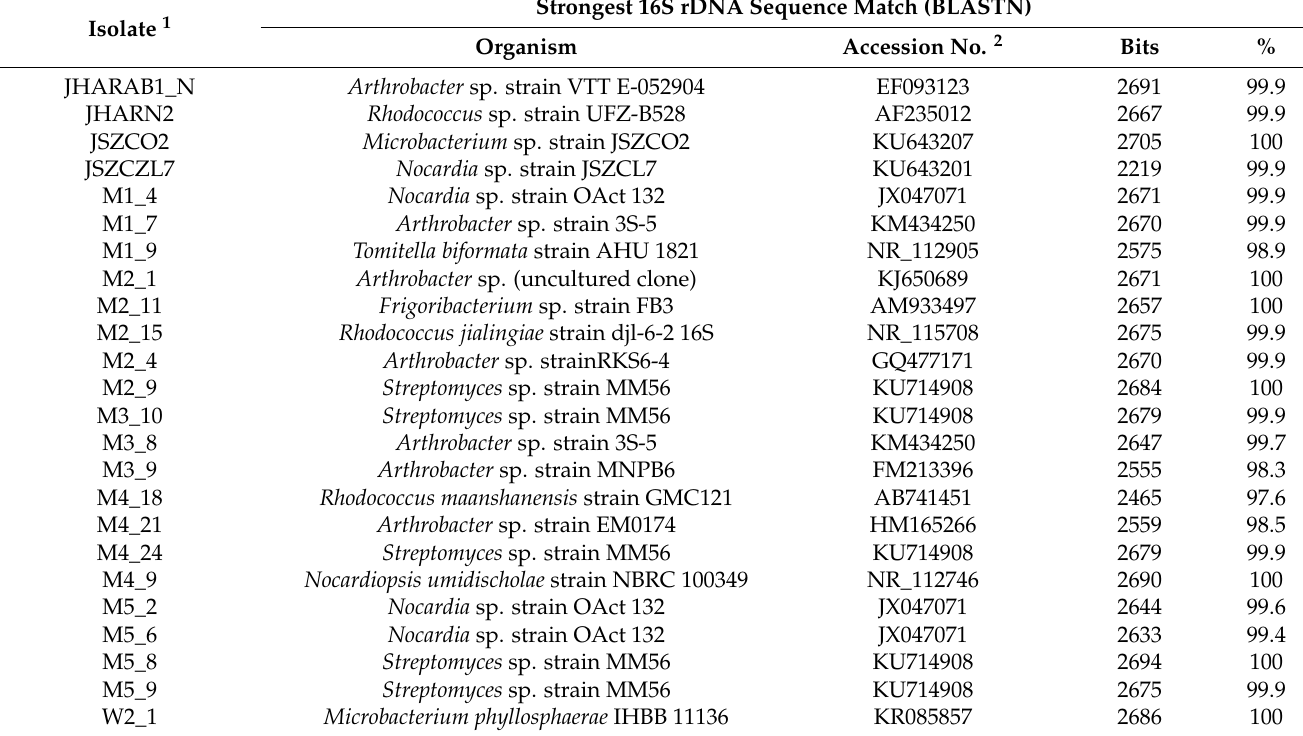
Table 1. Actinobacteria isolates from the Szczelina Chochołowska cave, with identification of the closest relatives determined on the basis of comparison of 16S rDNA